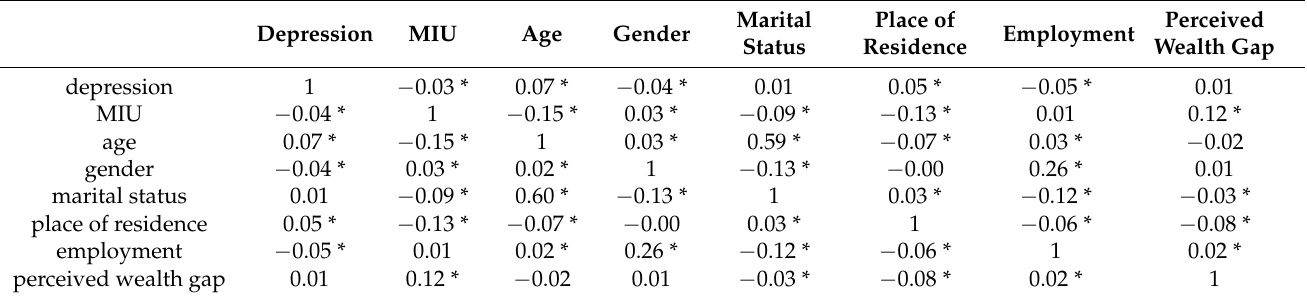
Table 2. Correlation matrix of the variables.